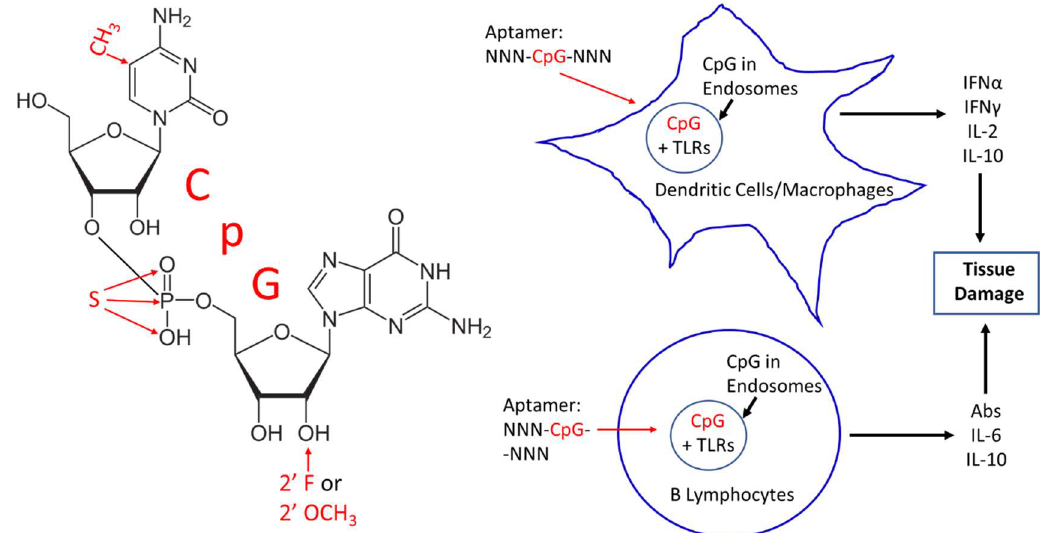
Figure 1. Left —2013 molecular structure of 2′-deoxycytidine-phosphate-2′-guanine (CpG) showing several potential remedies for CpG toxicity in red text such as methylation at the 5 position of cytosine, phosphorothioate (S or sulfur for oxygen) substitution in the phosphate linkage and 2′ fluoro (F) or 2′ O-methyl (O-CH 3 ) modifications. Right —schematic illustration of the possible in vivo toxicity mechanism caused by CpG segments in aptamers upon entry to endosomes where CpG segments can bind the Toll-like receptors (TLRs) 3, 7, 8, and 9 to induce cytokine (e.g., interferons (IFN) alpha and gamma, interleukins (IL) 2, 6, and 10) production and antibody secretion, potentially leading to unintended tissue damage.